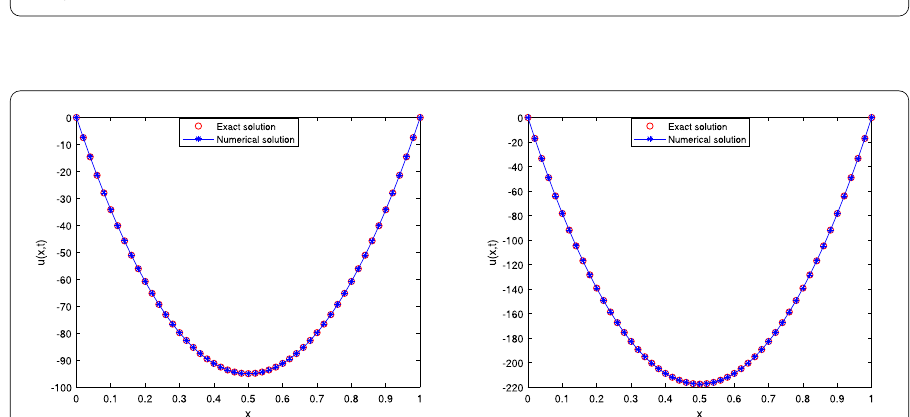
Figure 7 Approximate and exact solutions of Example 6.2 for n = 5 with final times T = 20 (left), T = 30 (right), and φ ( h ) = 2sin( h /2)